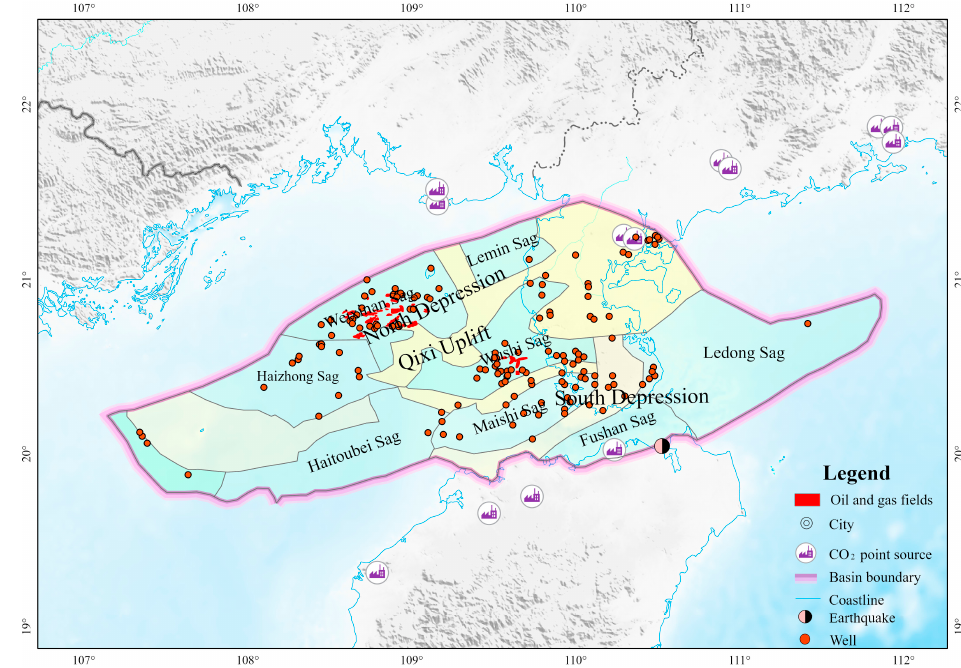
Figure 9. Petroleum exploration conditions of the Beibu Gulf Basin.